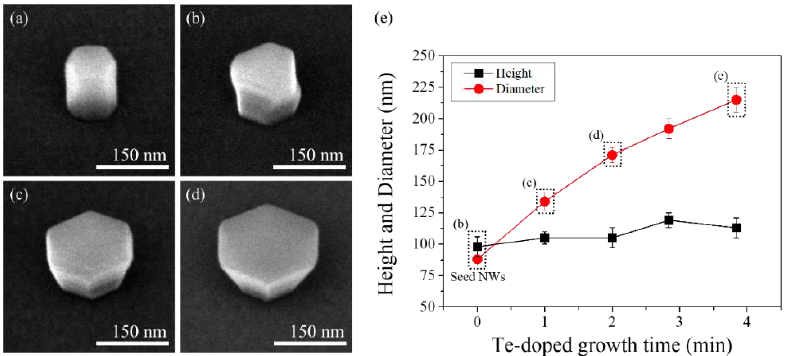
Figure 4. ( a ) Tilted-view SEM images of 1 min 40 s growth for seed NWs; tilted-view SEM images of grown Te-doped InAs NWs with the DETe flow (2.00 × 10 − 3 sccm) at each growth time (( b ) 1 min, ( c ) 2 min, and ( d ) 3 min 50 s) after 1 min 40 s seed NWs; ( e ) a plot showing Te-doped NWs’ (DETe flow: 2.00 × 10 − 3 sccm) heights and diameters as a function of the growth time. Seed InAs NWs grown for 1 min 40 s were ∼ 100 nm in height and ∼ 90 nm in diame-